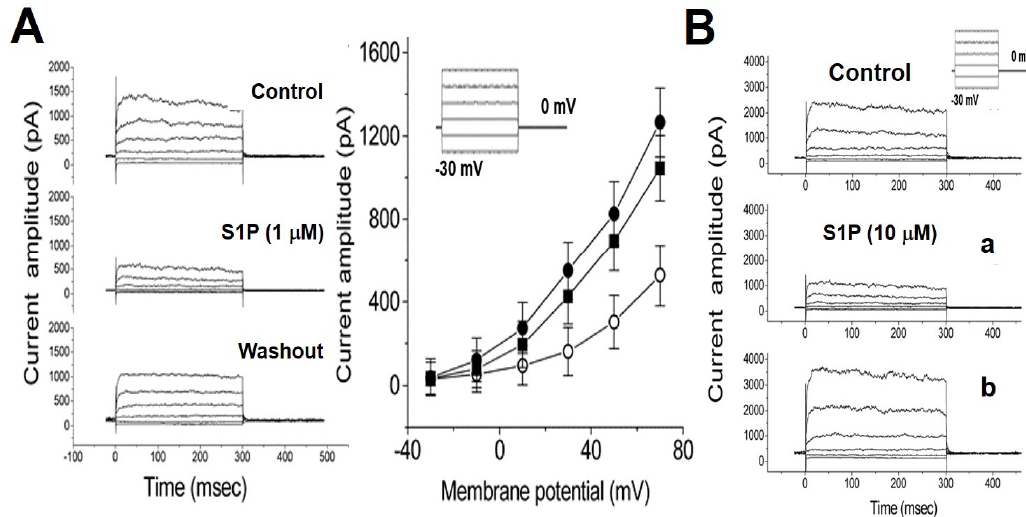
Figure 4. Effects of S1P on I K(Ca) in chromaffin cells. ( A ) Superimposed current traces (left panel) obtained in the control, exposure to S1P (1 µM), and washout. The cells were bathed in a normal Tyrode solution with 1.8 mM CaCl 2 , and the pipette solution containing 0.1 µM Ca 2+ . Averaged I-V relationships of I K(Ca) measured at the end of each voltage pulse (right panel) in the control ( ● ), exposure to 1 µM S1P ( ○ ), and washout ( ■ ). Each point represents the mean ± SEM ( n = 6 − 10, in four cultures). ( B ) Biphasic effects of high-dose S1P (10 µM) on I K(Ca) . Superimposed current traces obtained when the recording pipette was filled with ethylene glycol tetraacetic acid (EGTA, 0.1 mM). The uppermost part is the control. Time courses after the S1P (10 µM) application are at 1 (a) and 3 min (b). The pulse protocol is shown as an inset part of each related graph.